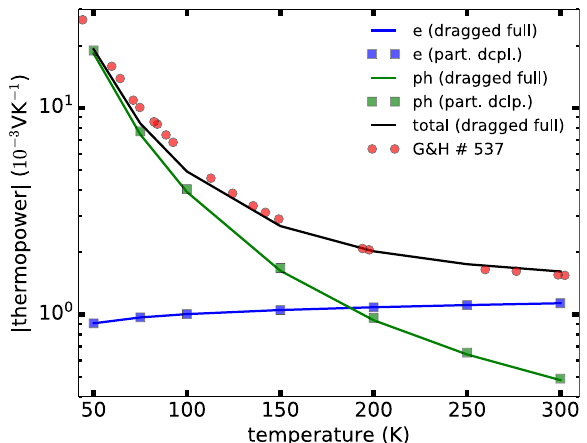
Fig. 3 Temperature dependence of the thermopower of silicon for an n -type carrier concentration of 2.7 × 10 19 cm − 3 . The red